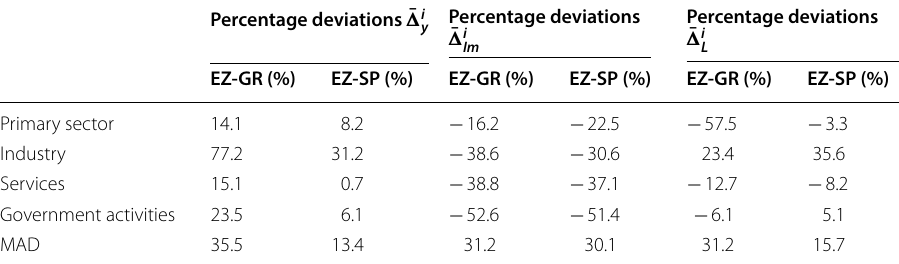
Table 5 Percentage deviations of the EZ sectoral multipliers from those of the Greek and Spanish economies